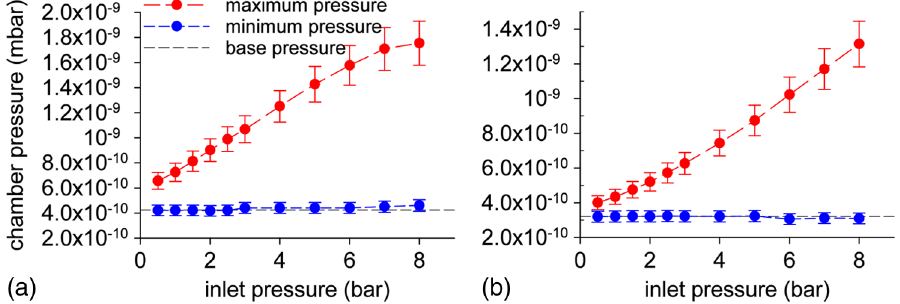
FIG. 15. Plot of pressure at (a) differential chamber and (b) dump chamber, versus inlet pressure, for 1 s period, 50% duty cycle, variable helium